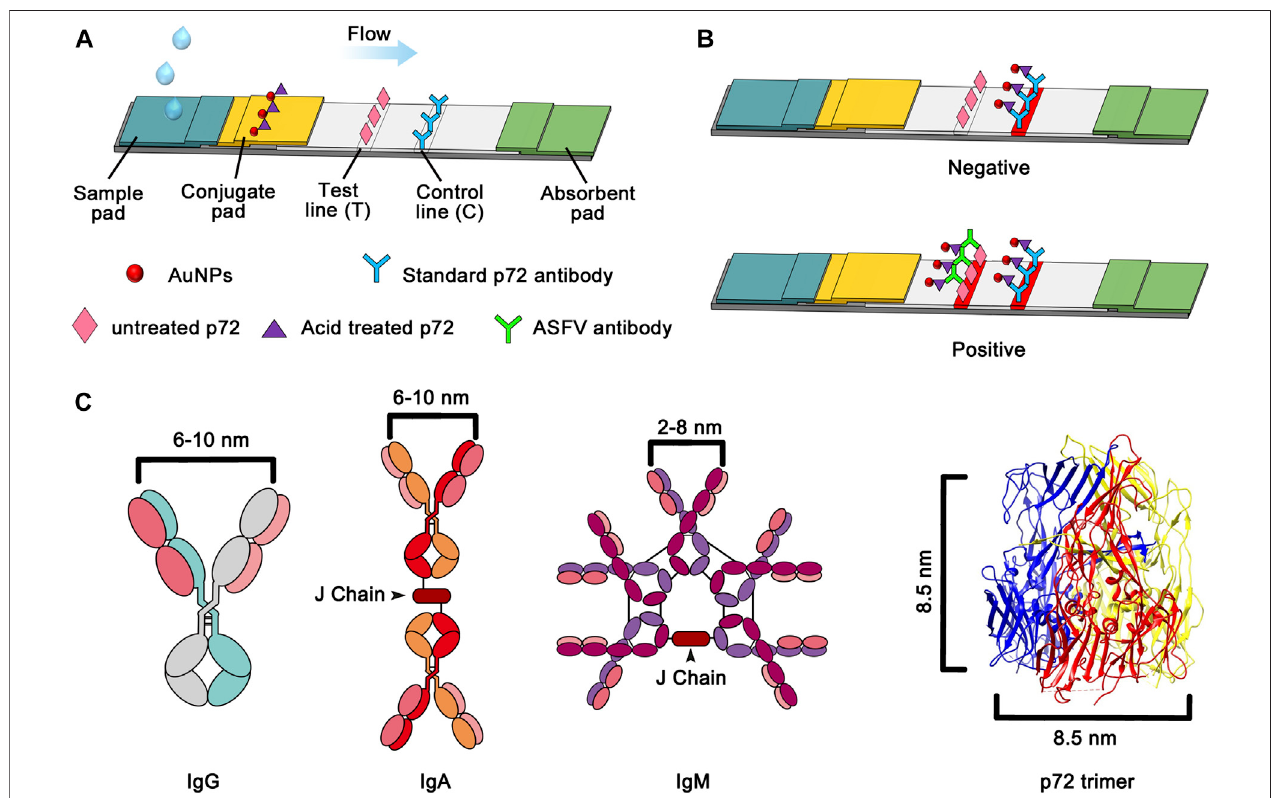
FIGURE 1 | (A) Schematic of the proposed sandwich lateral fl ow strip for ASFV antibody detection. (B) Image of the lateral fl ow assay for positive and negative samples (C) Schematic illustration of the distances between the two Fab domains within immunoglobulin and the diameter of the p72 trimer.